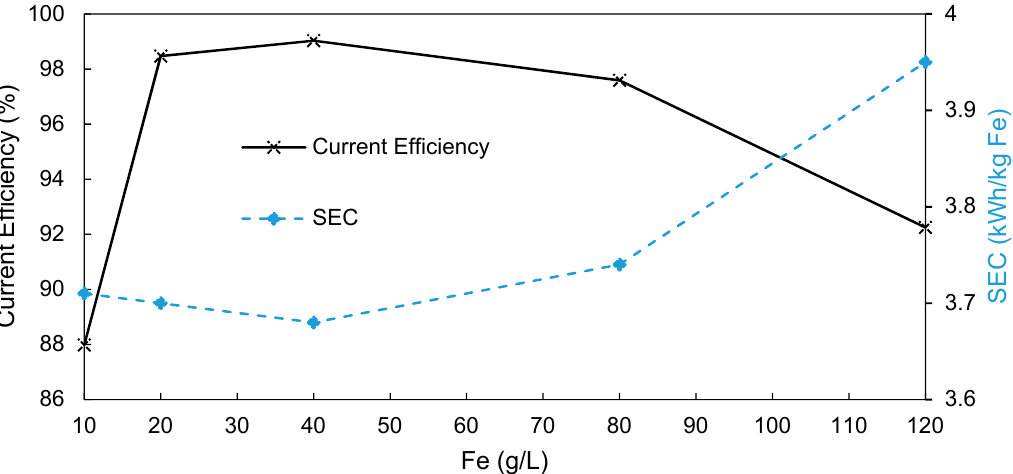
Figure 8. The effect of the initial iron concentration of the catholyte on the current efficiency (primary y -axis) and the specific energy consumption (secondary y -axis) when using a FAB-PB-130-divided EW cell.